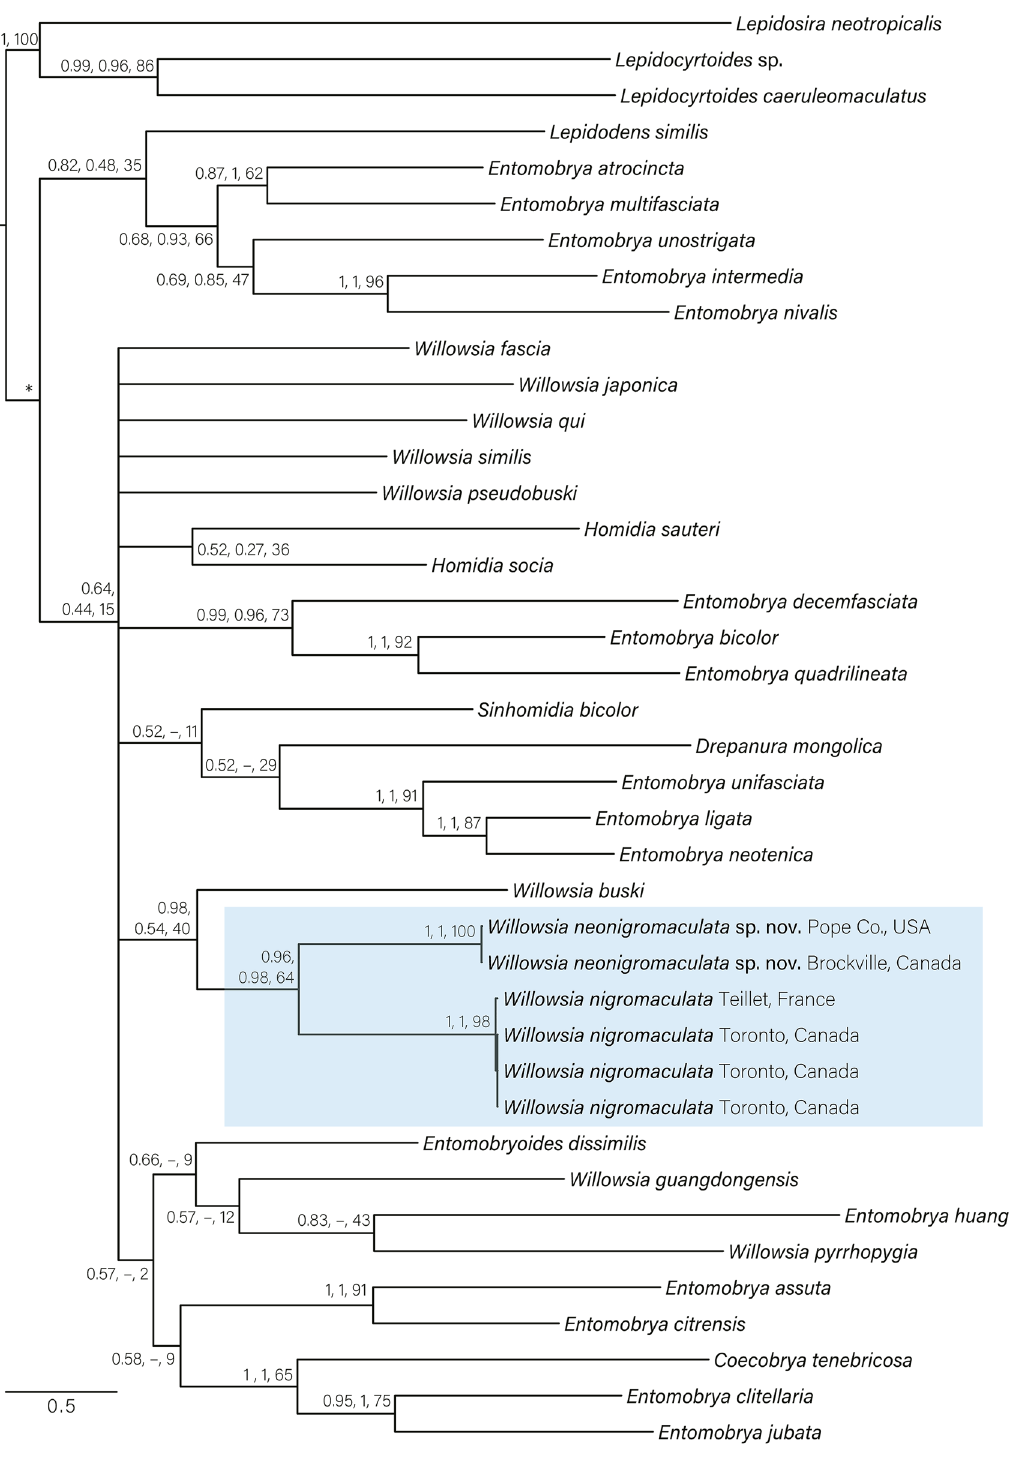
Fig. 11. Bayesian consensus tree estimated with MrBayes for Entomobryinae, including the clade comprised of Willowsia nigromaculata (Lubbock, 1873) from France and Canada and W. neonigromaculata sp. nov. from the USA and Canada (highlighted). MrBayes and BEAST posterior probabilities and RAxML bootstraps are indicated at each node, respectively. The ingroup node constrained as monophyletic for all phylogenetic analyses is indicated with an asterisk